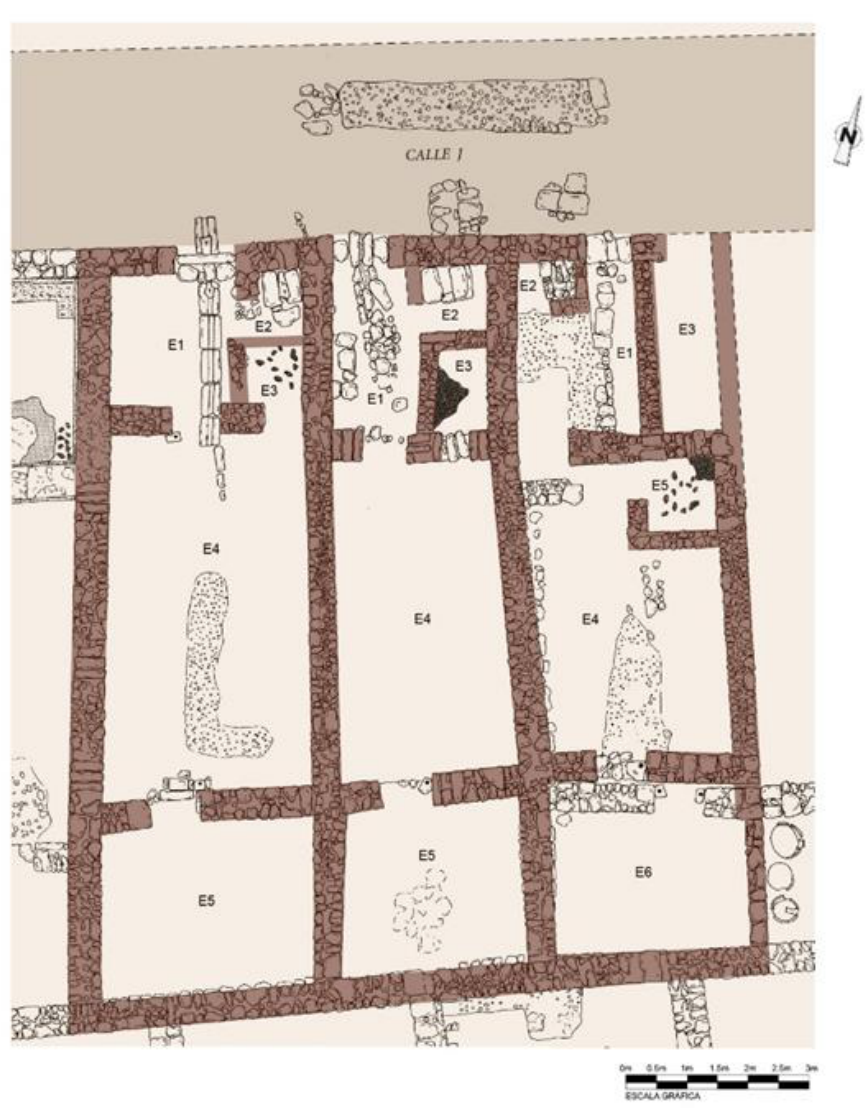
Figure 26. Houses 103, 102, and 101, from west to east. Plan and room distribution.